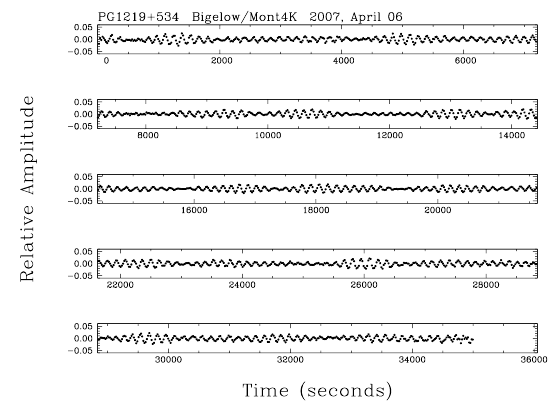
Figure 2. Expanded view of the light curve obtained on 6 April 2007 in units of fractional brightness intensity and